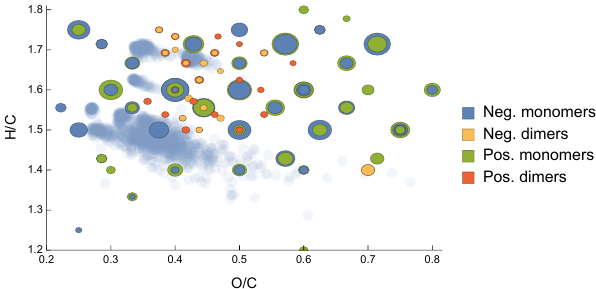
Figure 8. Van Krevelen plot comparing online experimental mea- surements by an AMS (blue shading) (Fig. 18 in Mackenzie-Rae et al., 2017) with assigned formulas from the ESI mass spectra (RI > 5%) in the negative mode (blue ≤ C 10 , yellow > C 10 ) and positive mode (green ≤ C 10 , red > C 10 ). Circle size is proportional to relative signal intensity in either mode.